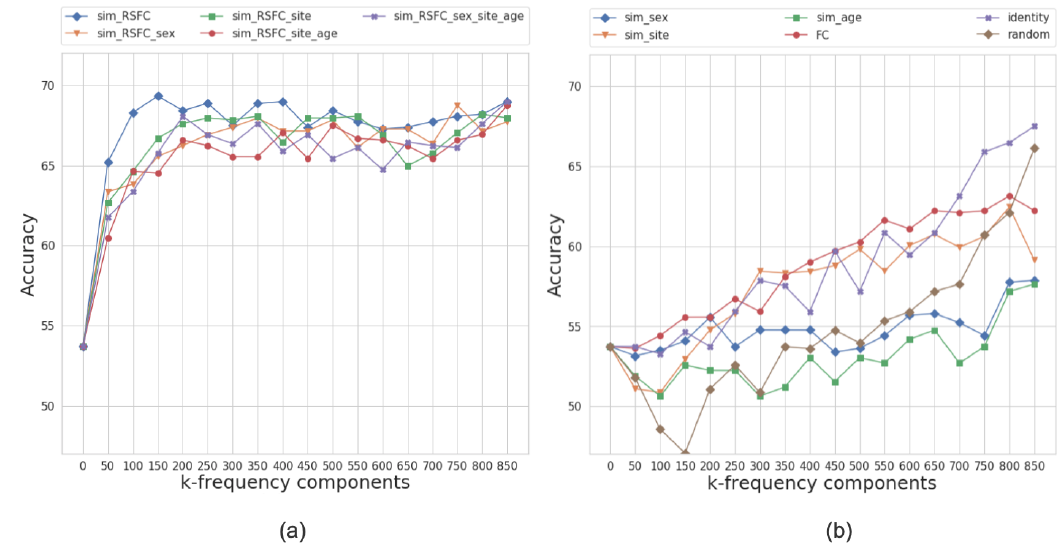
Figure 6. The average accuracy of the classifier over ten folds on frequency-filtered feature vectors for the ABIDE dataset. The plot shows the cumulative contribution of frequency components to the classification accuracy. We split the graphs into two categories based on the performance of models at different frequency regimes, i.e., those that yield higher classification accuracy at ( a ) low or ( b ) high frequencies. The eigenvalues that correspond to k-frequency components are sorted in order of the increasing